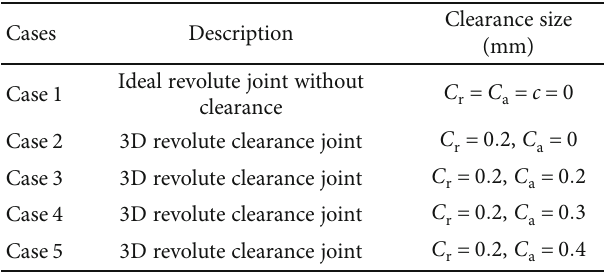
Table 4: Di ff erent axial clearance sizes of 3D revolute clearance